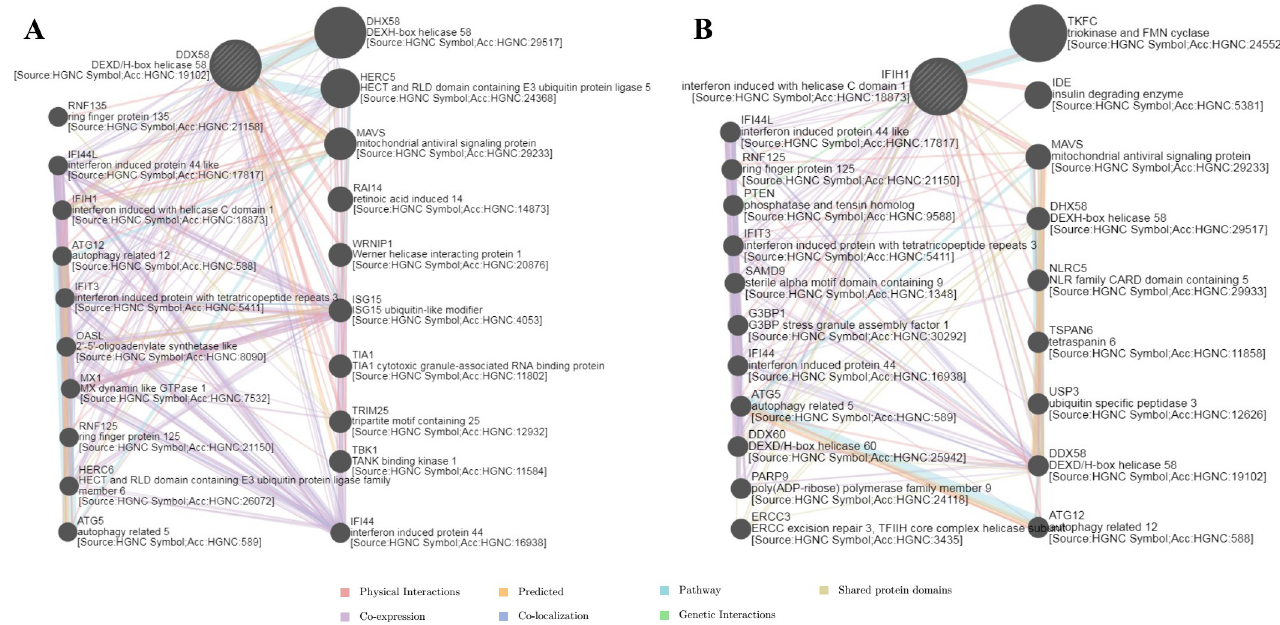
Fig 7. Biological interaction network of DDX58 (A) and IFIH1(B). Different colors represent diverse bioinformatics